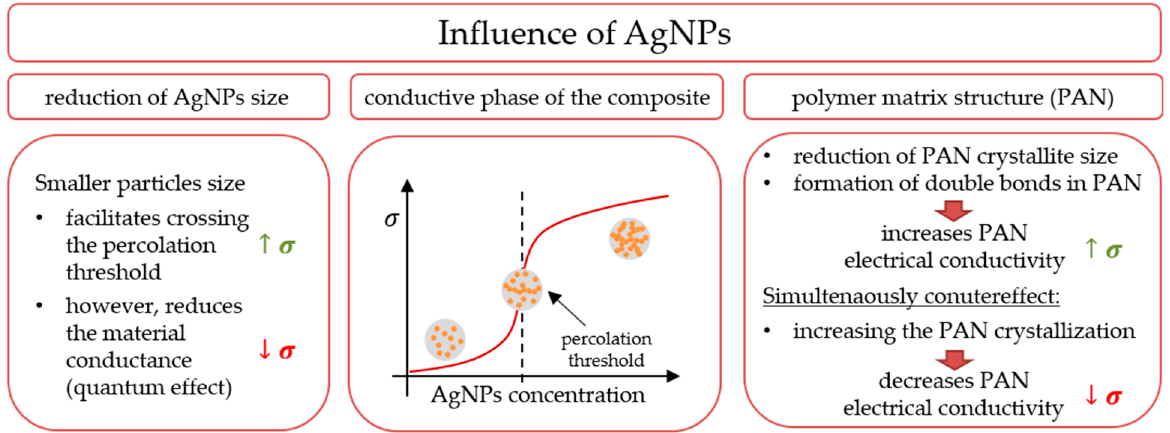
Figure 10. Impact of silver nanoparticles on electrical conductivity and structure of nanocomposite PAN/Ag fi bers ( σ —conductivity of material, ↑ and ↓ —increase and decrease).